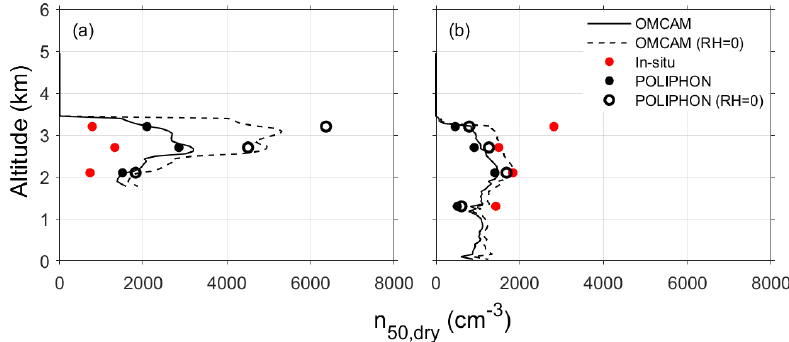
Figure 7. The n 50,dry concentrations estimated from CALIPSO satellite data using OMCAM (solid line) and POLIPHON (black dots) incorporated from Georgoulias et al. (2020) and in situ aircraft observations (red dots) adopted from Tsekeri et al. (2017) over the land (a) and sea (b) surface close to the Thessaloniki region. The dotted line and unfilled black circles represent the n 50,dry estimated from OMCAM and POLIPHON, respectively, when hygroscopicity correction is not